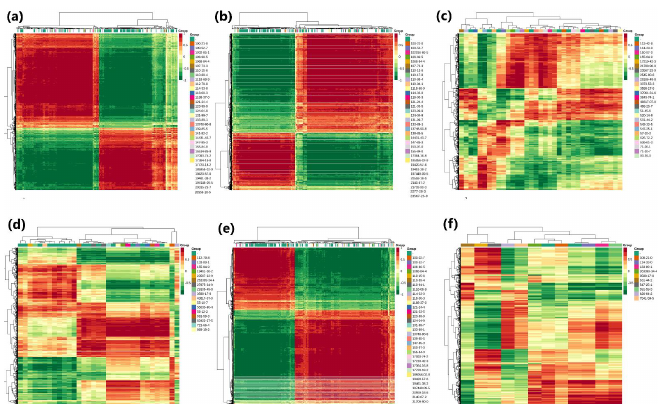
Figure 10. Heat maps of correlation coefficient matrices between DAMs and DEGs with the Pearson correlation coefficient above 0.8, which resulted from the combined analysis of transcriptome and metabolome metabolites in comparison groups of seedling samples of cotton seeds pre-treated with NaCl for 0.5, 1, and 1.5 h, as well as the CK group. The color gradient from red to green demonstrates a positive to a negative correlation between seedling comparison groups: ( a ) CK-vs.-N0.5, ( b ) CK- vs.-N1, ( c ) CK-vs.-1.5, ( d ) N0.1-vs.-N1, ( e ) N0.5-vs.-N1.5, and ( f ) N1-vs.-N1.5.